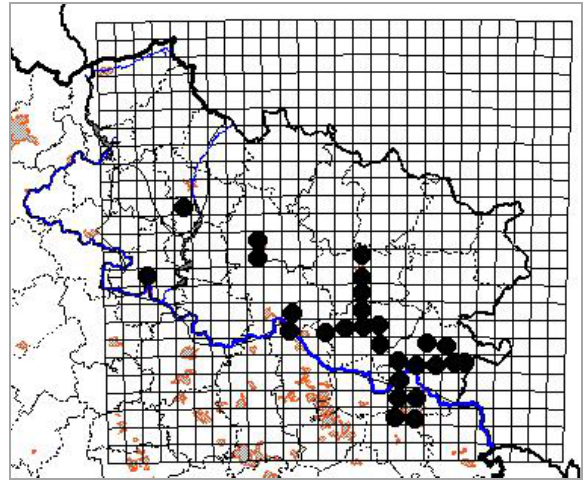
Fig. 14. The map of the distribution of Conium maculatum L. in the Starobilsk grass-meadow steppe